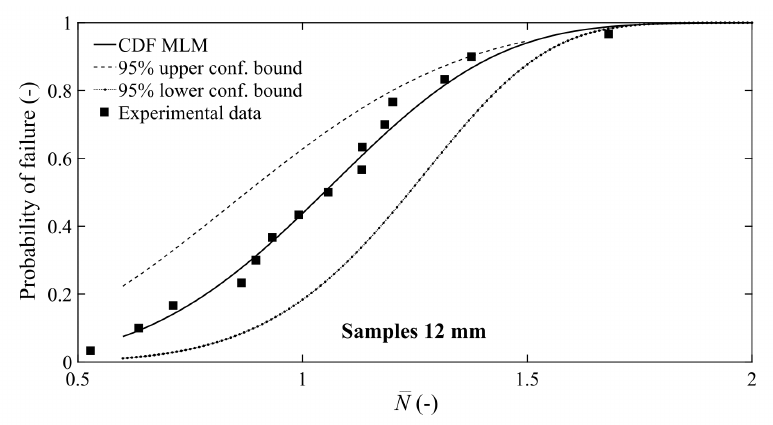
Figure 11. CDF for the specimens of 6 mm in diameter.